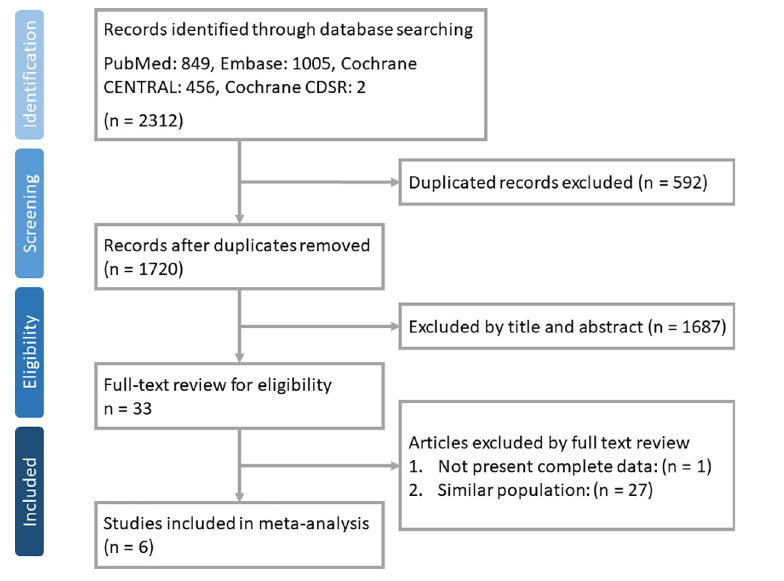
Fig 1. Flow chart of study